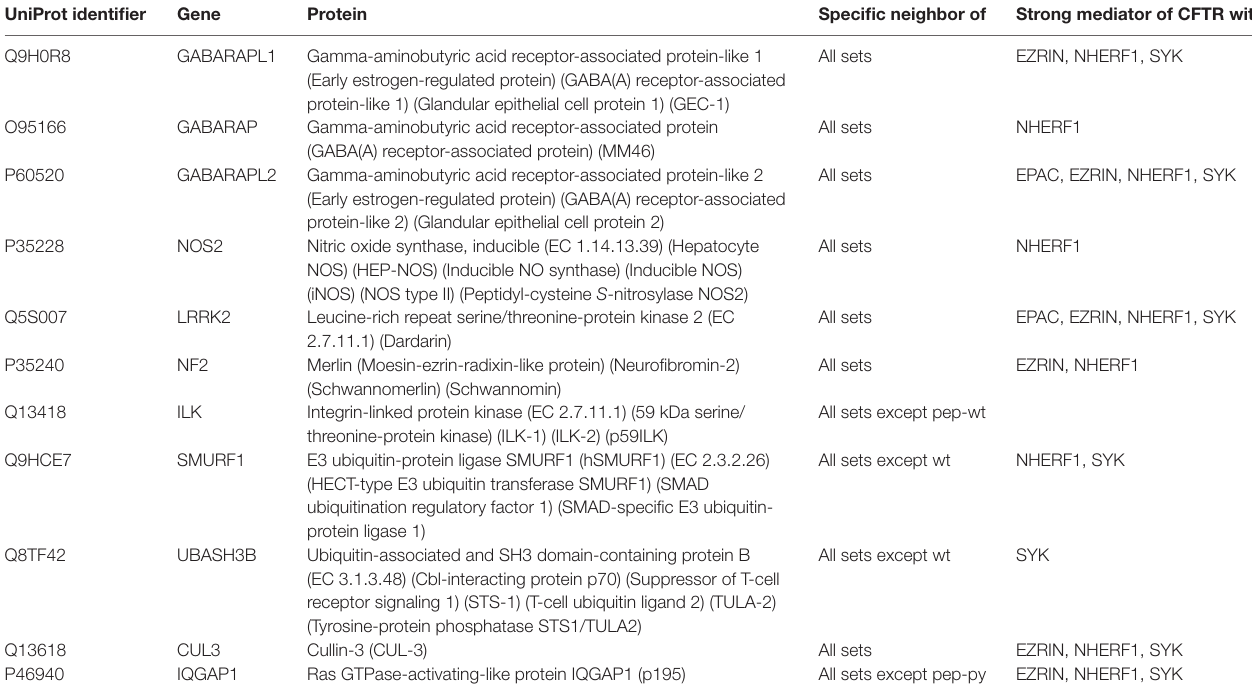
TABLE 3 | Hits selected for validation. UniProt identifier Gene Protein Specific neighbor